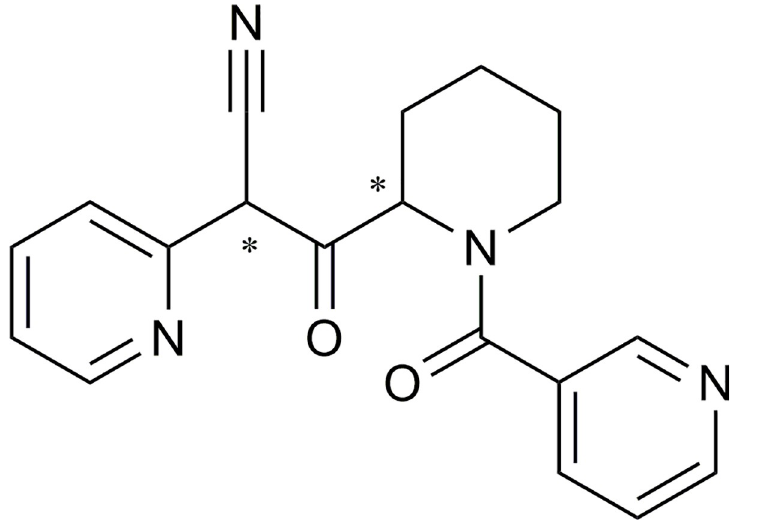
Fig 6. Chemical structure of compound